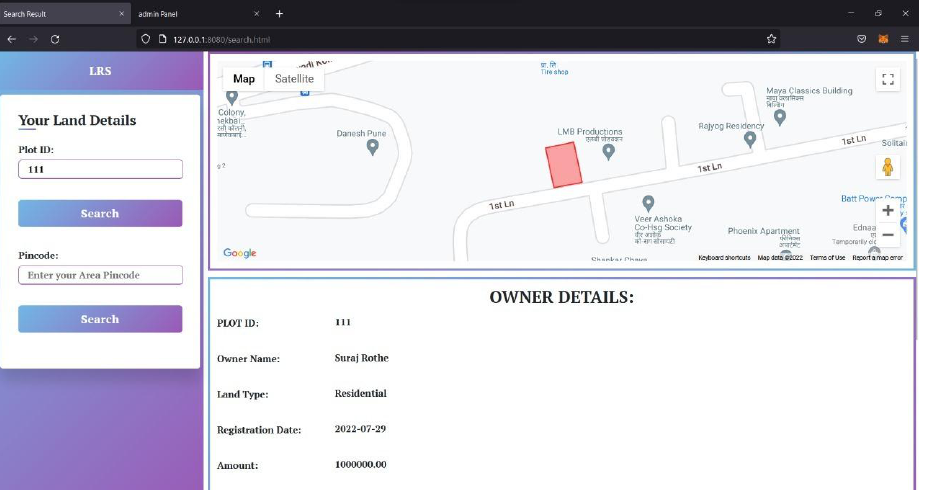
Fig. 6. Prototype of the